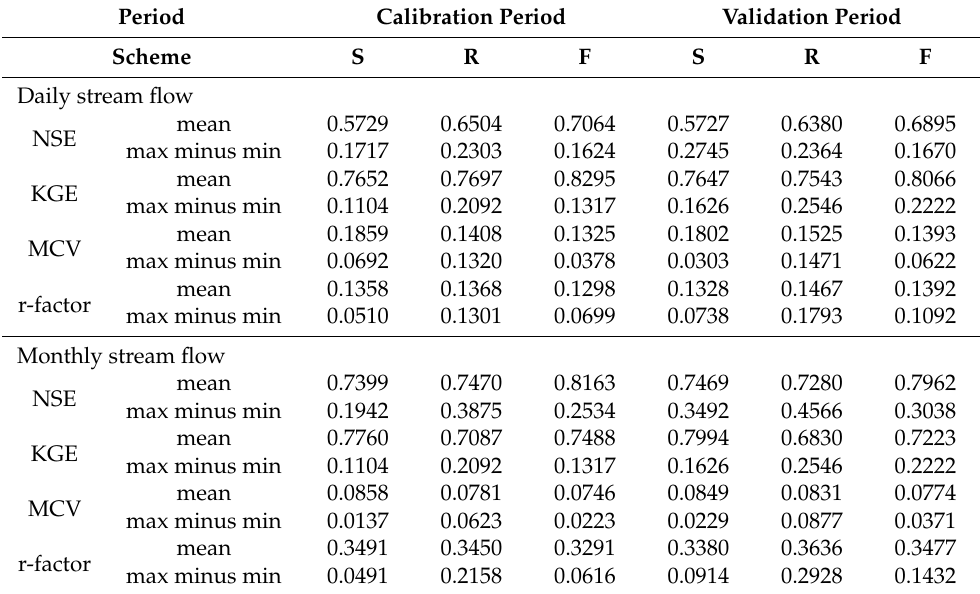
Table 4. Performance and uncertainty of simulated daily and monthly stream flow by each calibration scheme for calibration and validation